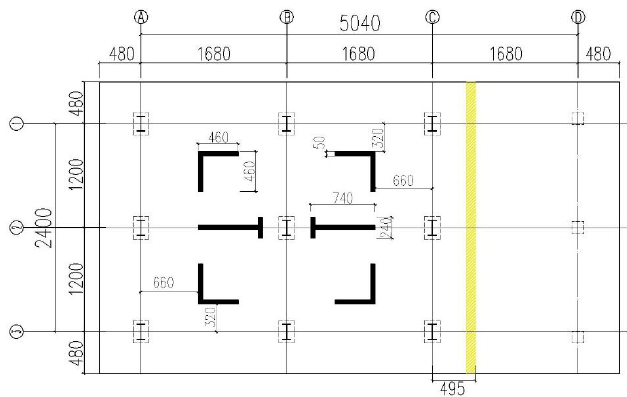
Figure 6. Shear wall layout plan.